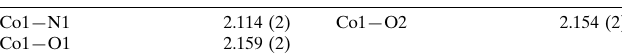
Selected bond lengths (A˚